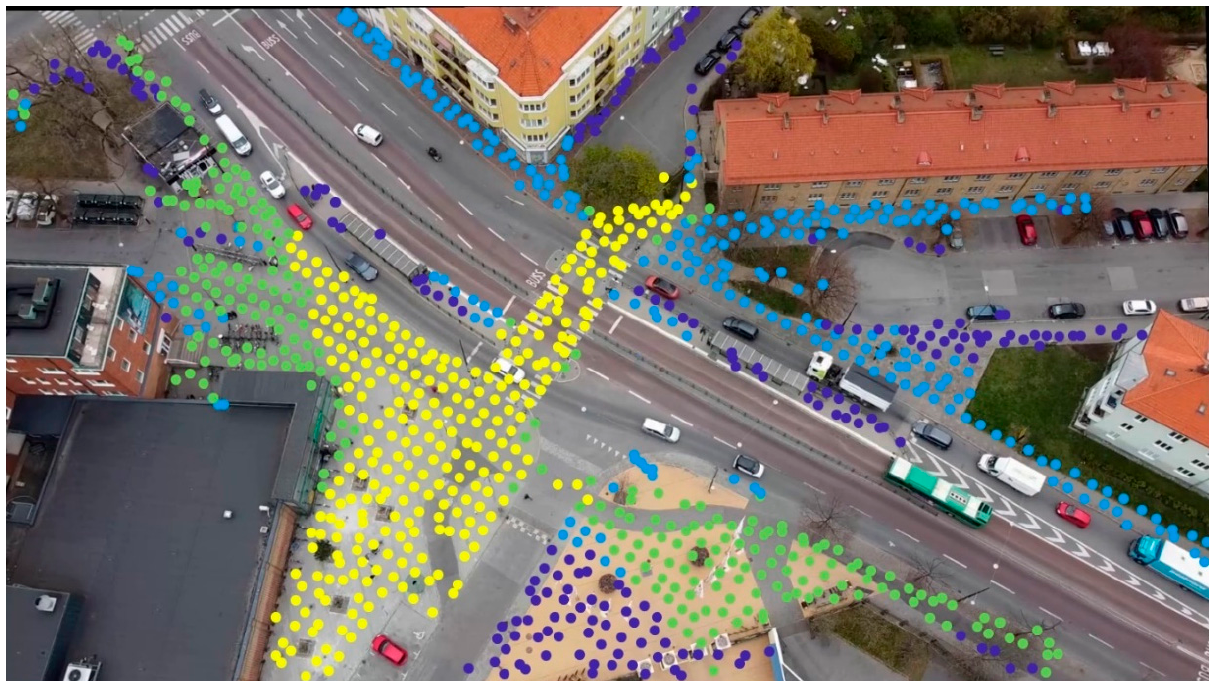
Figure 6. Integration map of Folkets Park with four separate integration levels (yellow, green, light blue and dark blue).